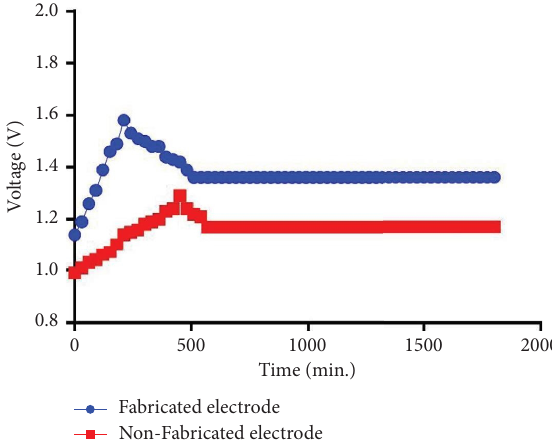
Figure 4: Comparison of voltage with fabricated and non- fabricated